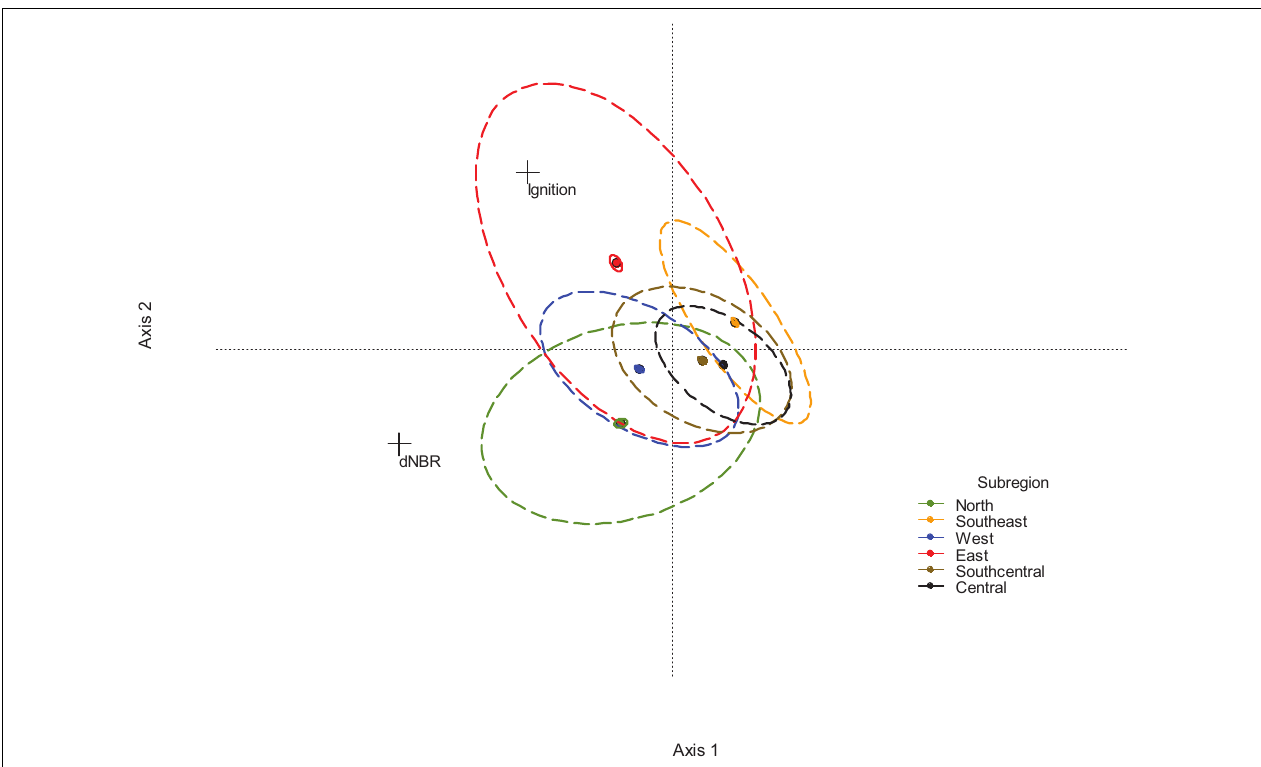
FIGURE 10 | Centroids and ellipses of SEs (solid lines) and 95% confidence bounds (dashed lines) for six subregions of the Mojave Desert along gradients of predicted burn severity (difference normalized burn ratio; dNBR) and probability of ignition. The centroids and ellipses were derived from a Redundancy Analysis with 500 randomly selected points in each subregion from which values of dNBR and ignition probability were extracted. Monte Carlo permutation tests ( N = 999) and Tukey HSD contrasts indicated the subregions differed in both location (centroids) and dispersion